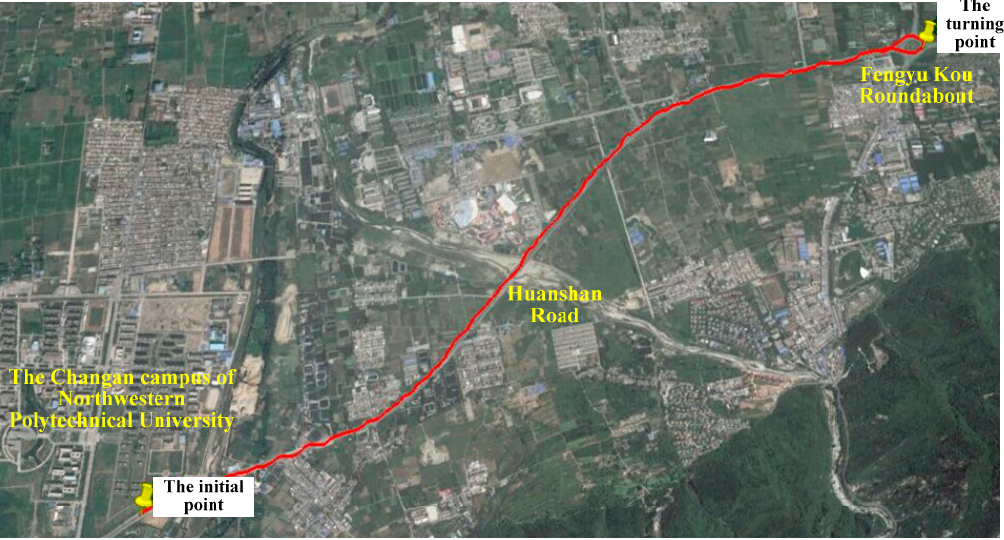
Figure 3. Vehicle traveling trajectory.